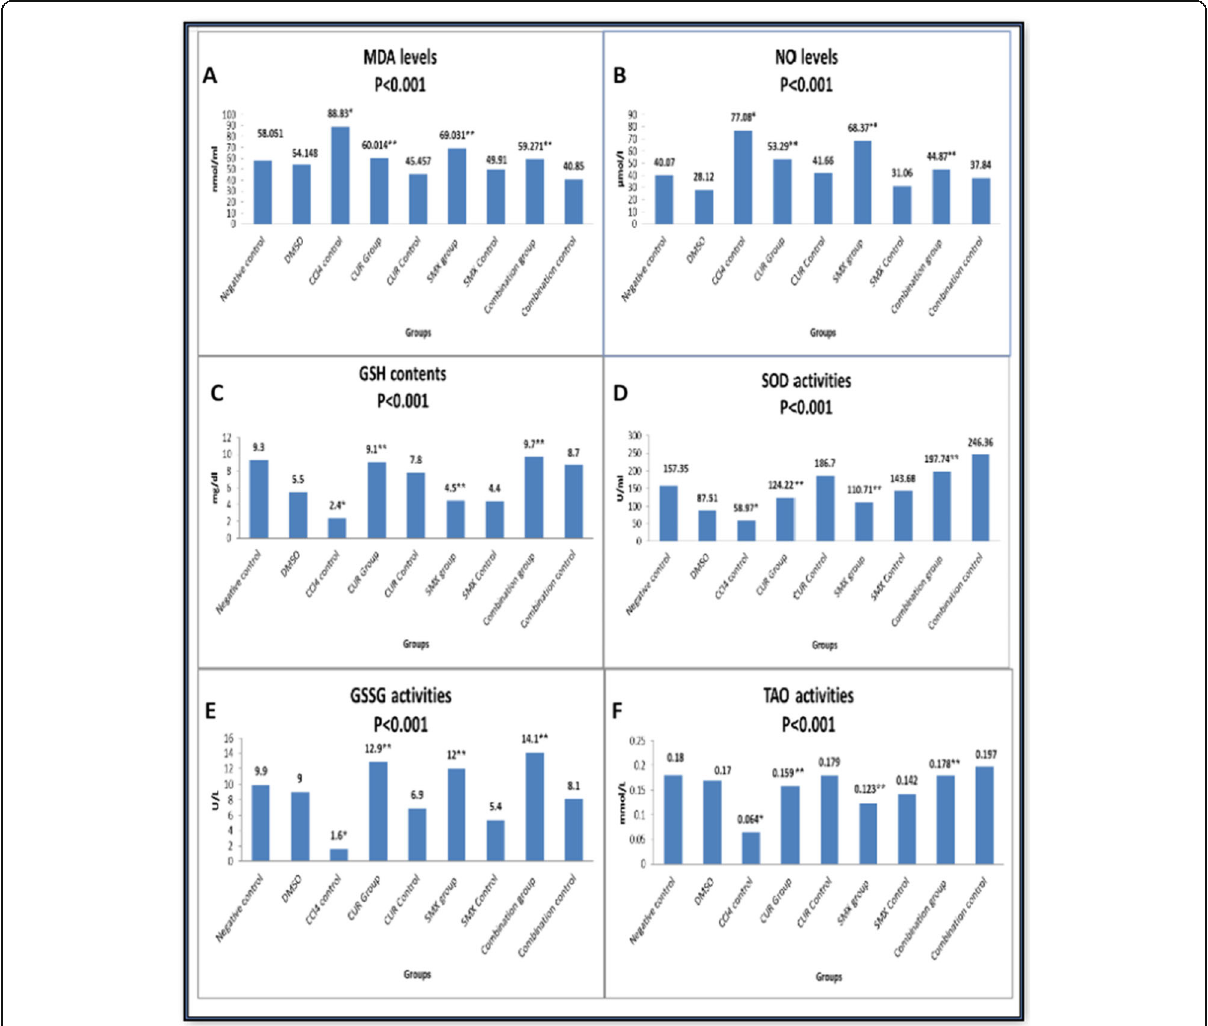
Fig. 6 Effect of curcumin and sulfamethoxazole on antioxidants in all studied groups. a MDA levels, b O levels, c GSH contents, d SOD activities, e GSSG activities, and f TAO activities. Results were expressed as mean. (*) Compared with normal control, (**) Compared with CCl 4 control showed a highly significant difference from control value at ( p <